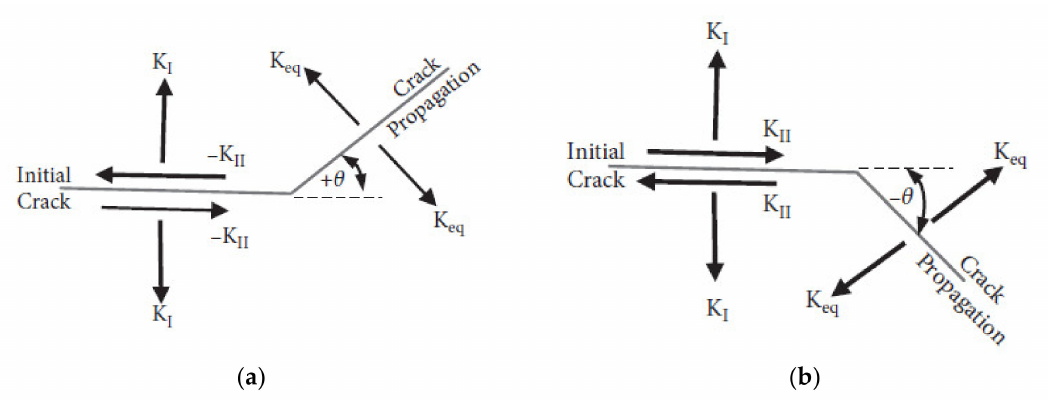
Figure 2. Crack growth angle ( a ) K II positive and ( b ) K II negative.